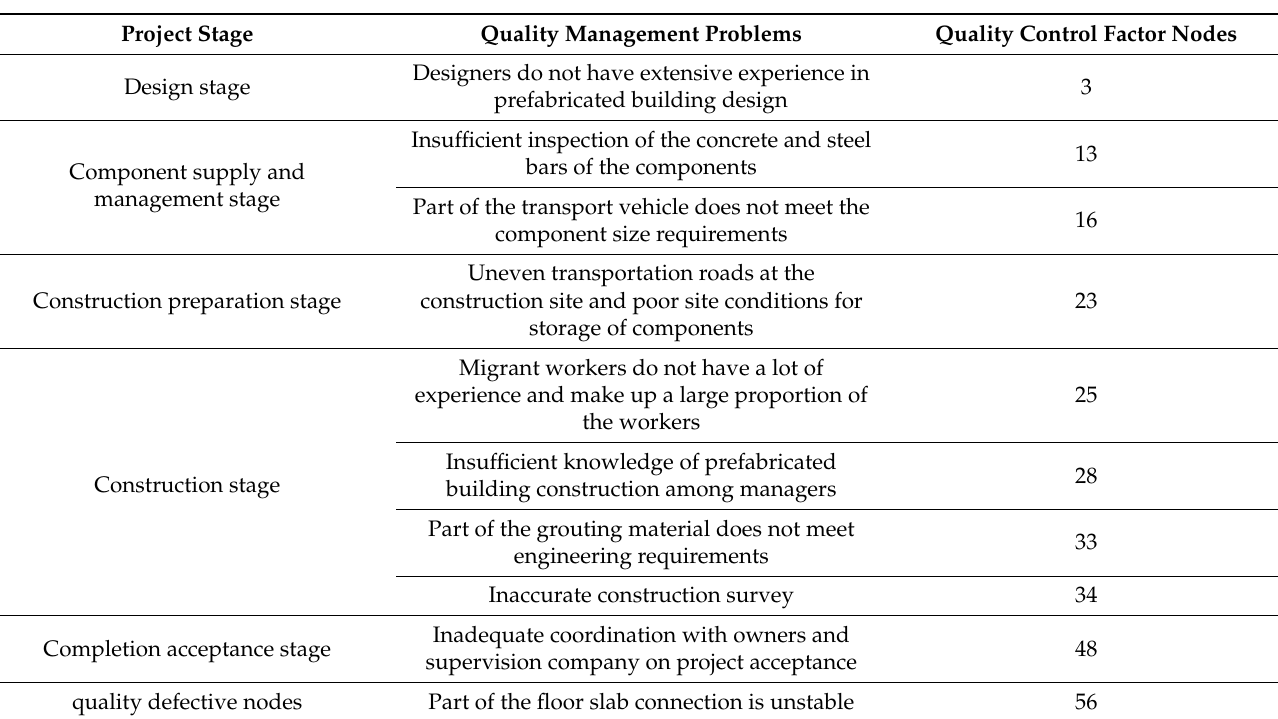
Table 3. Quality management problems and quality control factor nodes of Project